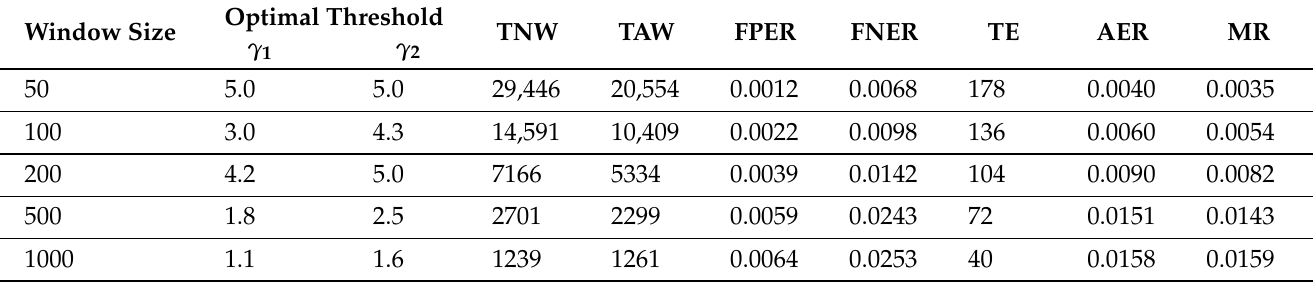
Table 9. Performance evaluation using optimum threshold value (DoS attack).